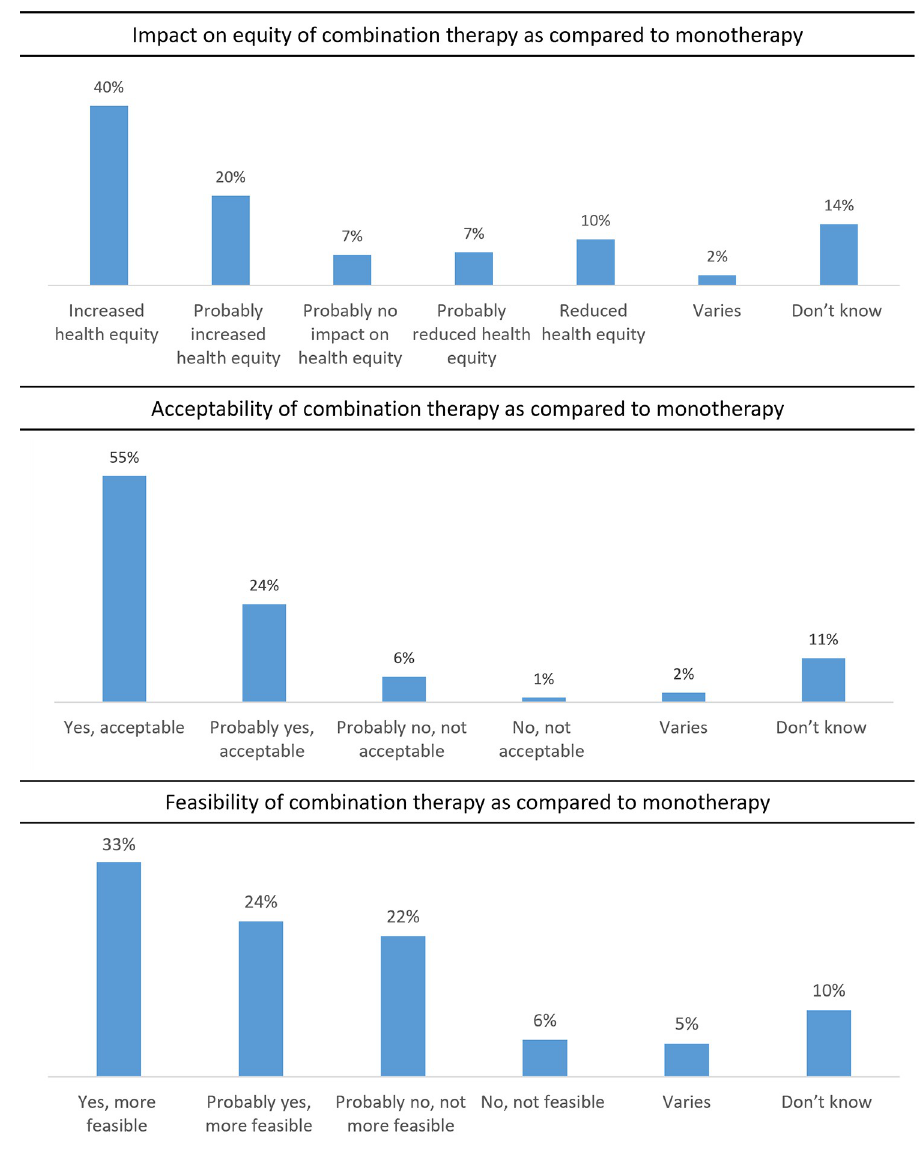
Fig 3. Impact on equity, acceptability, and feasibility of combination therapy as compared with